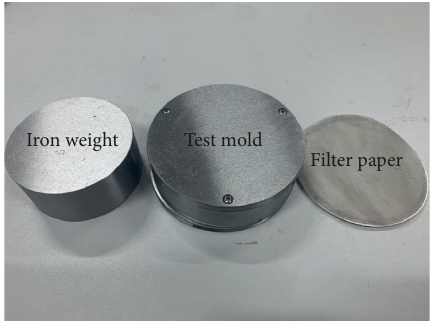
Figure 6: Measuring instrument for a water retention rate of cement slurry.